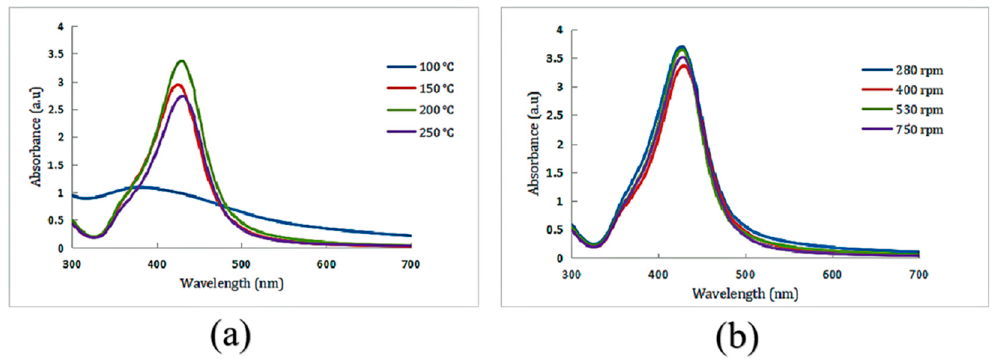
Figure 2. ( a ) UV ‒ Vis spectra of glycyrrhizin-reduced AgNPs at different hotplate temperatures, ( b ) UV-Vis spectra of glycyrrhizin-reduced AgNPs at different stirring speeds. The UV-Vis spectrum indicated an SPR peak at 419 nm (Figure 2b), which